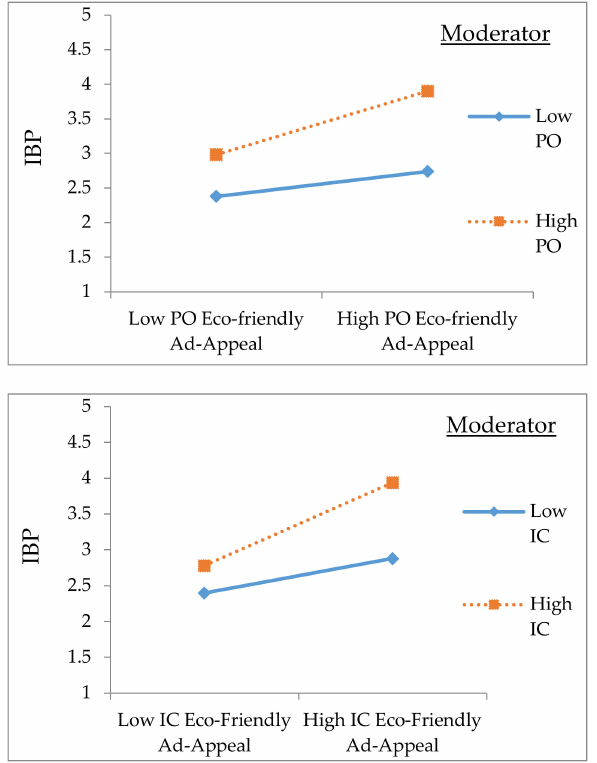
Figure 2. Moderation of the PO and IC